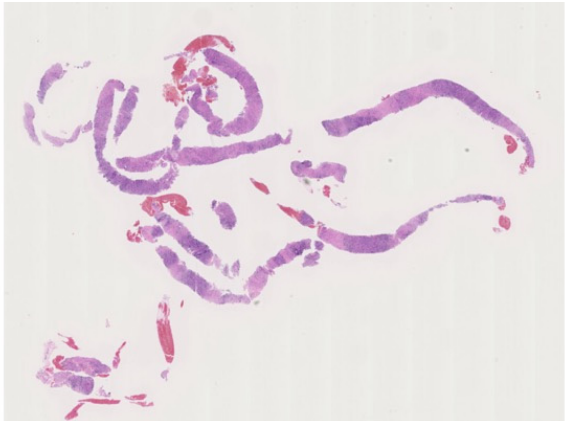
Figure 4. Macroscopic findings of specimens obtained using EUS-guided fine needle biopsy (EUS-FNB) with a 22G needle yielded adequate specimens for histopathological diagnosis.